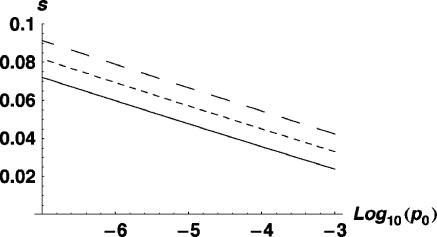
Selection Intensity Needed to Explain a Transient PolymorphismIntensity of selection, s, needed to explain a current frequency of 0.8 (solid line), 0.4 (short-dashed line), or 0.1 (long-dashed line) as a function of the initial allele frequency measured in units of log10, assuming equation 1.